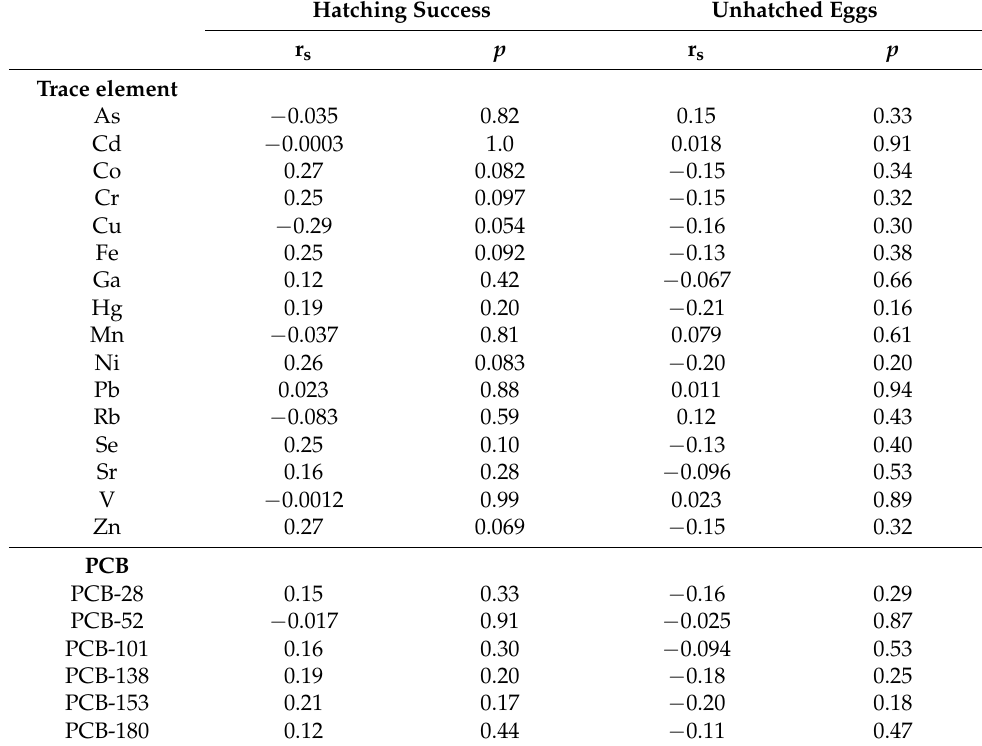
Table 4. Spearman’s correlation coefficients (r s , p ) measuring the strength of the association between trace element or PCB concentrations and hatching success or unhatched eggs with no visible embryos. Hatching Success Unhatched Eggs r s p r s p Trace